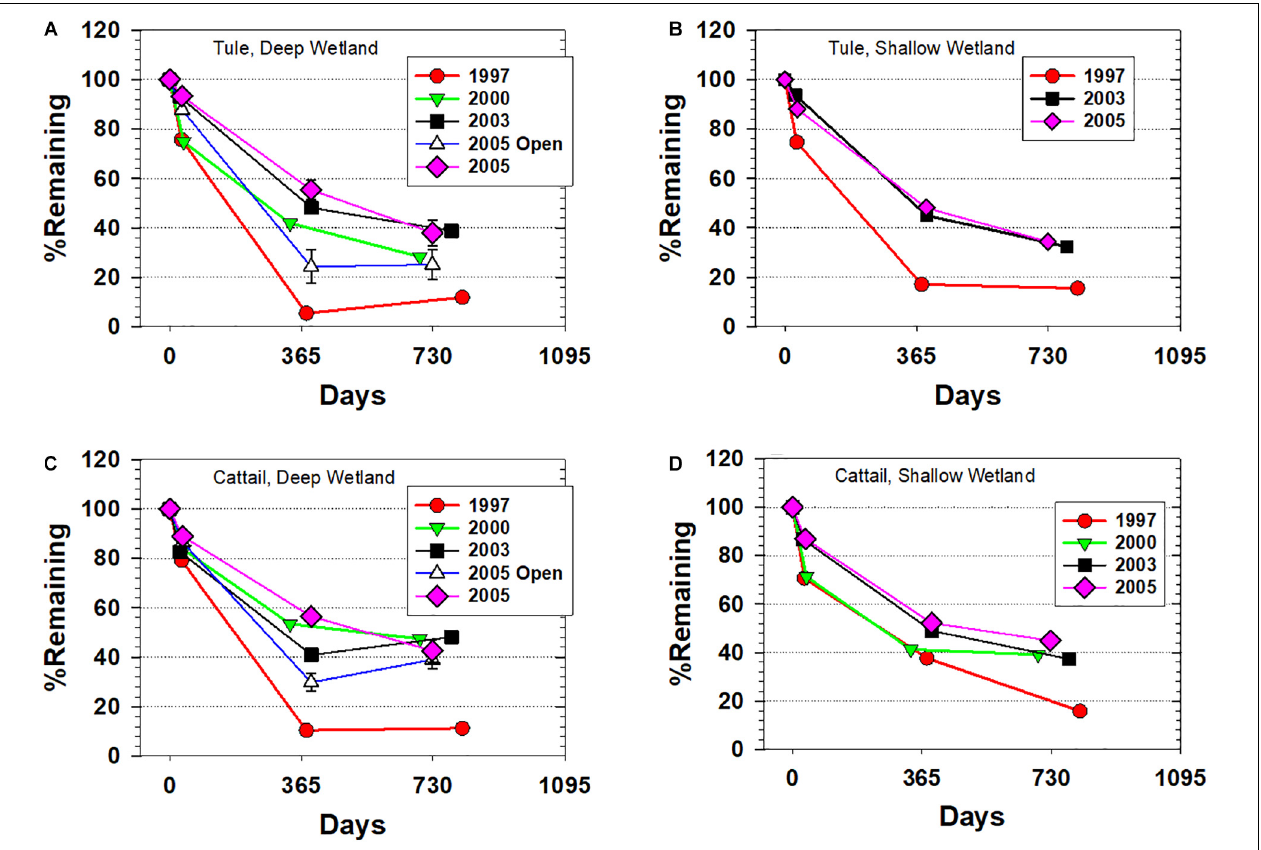
FIGURE 2 | Ash-free percent remaining for all sampled litterbags versus time across the four deployments. (A) Tule litterbags from the Deep wetland, (B) Tule litterbags from the Shallow wetland, (C) Cattail litterbags from the Deep wetland, and (D) Cattail litterbags from the Shallow wetland. Error bars for select samples represent the difference between two litterbags that were averaged. “2005 Open” refers to a special deployment in open water near the water inlet.